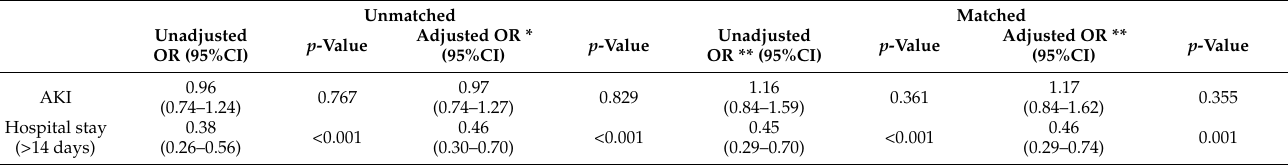
Table 3. AKI incidence and days of hospitalization (>14 days) adjusted for laparoscopic surgery in the matched sample.